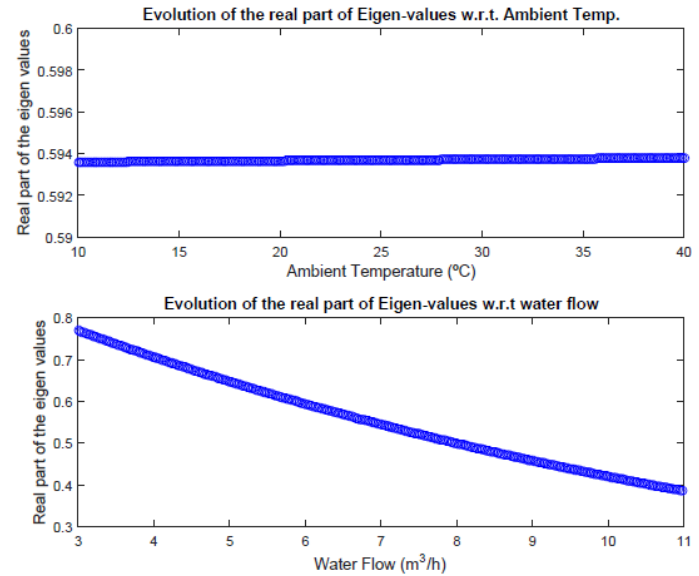
Figure 8. Real part of fluid eigenvalues w.r.t flow ( bottom part) and ambient temperature ( upper